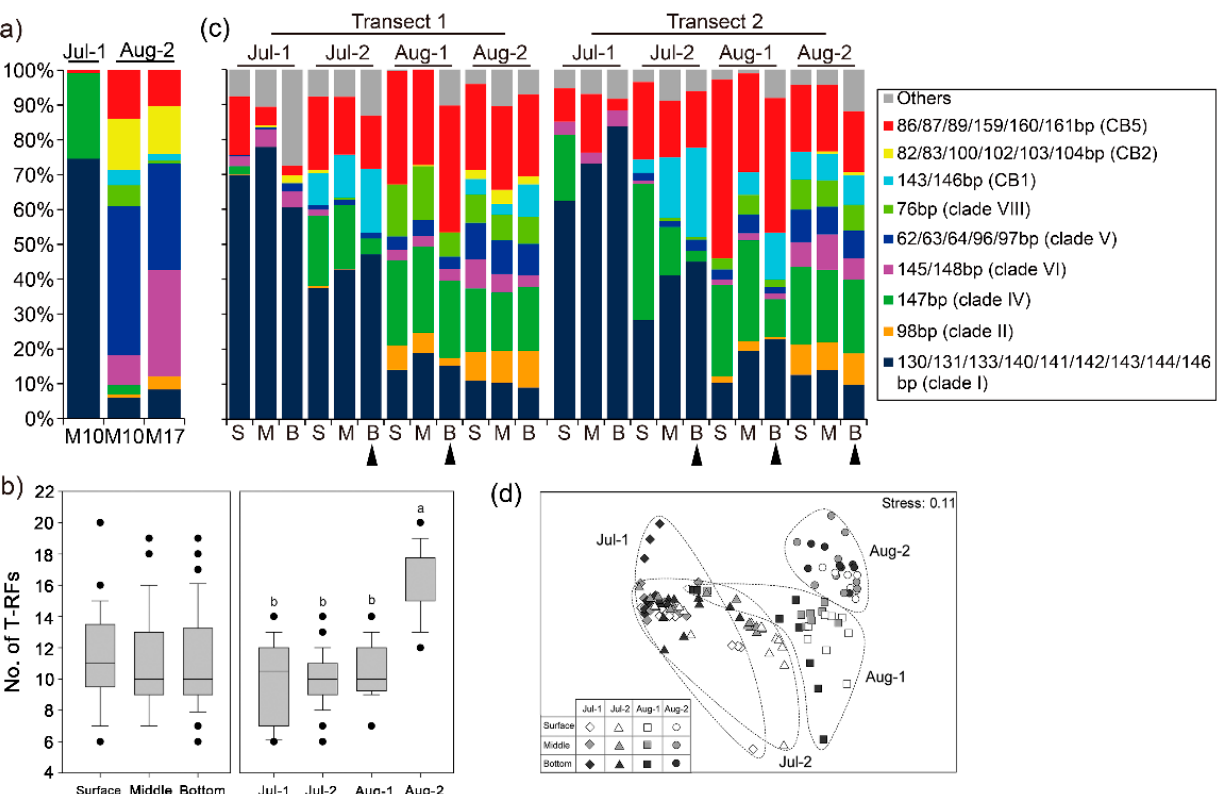
Figure 6. Variations of the Synechococcus genotypes along the two transects during four cruises across all depth from the result of clone library ( a ) and T-RFLP ( c ). S: surface, M: middle, B: bottom. The black triangles indicate the hypoxic layer. And variations in the number of terminal restriction fragments (T-RFs) of the Synechococcus 16S–23S internal transcribed spacer of rDNA are also shown ( b ). Box plots showing T-RF richness were similar among the surface, middle, and bottom layers, but significantly higher in late August (Aug-2) cruises than other samples collected in middle (Jul-1) and late July (Jul-2) and early (Aug-1) ( b ). Different letters in ( b ) indicate significant differences ( p < 0.05). The multidimensional scaling plot showing differences in genotype assemblages ( d ).